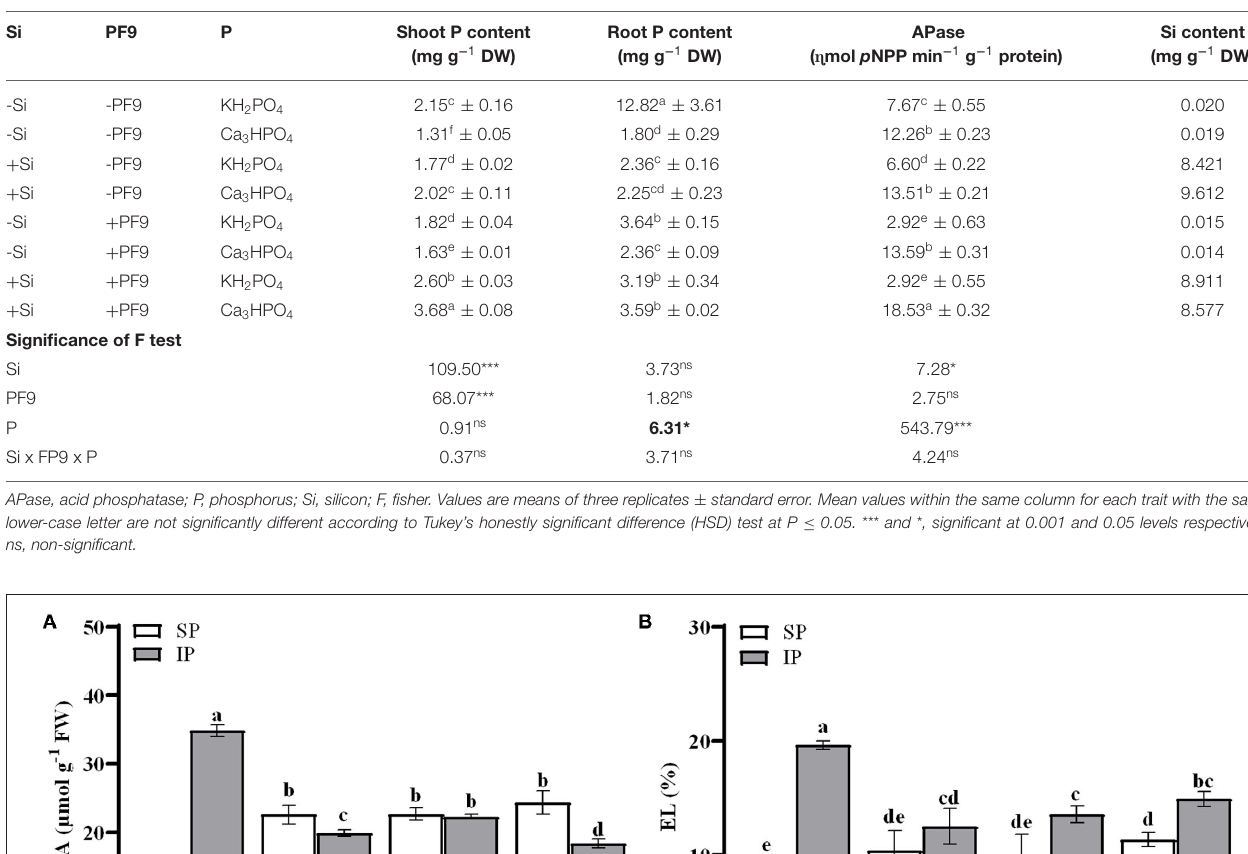
TABLE 2 | Effect of 3mM Si treatment, PF9 strain inoculation, and their combination on shoot and root P content, APase activity, and Si content of Medicago sativa (OL population) plants grown under 250 µ mol of soluble (KH 2 PO 4 ) or insoluble (Ca 3 HPO 4 ) phosphorus conditions.